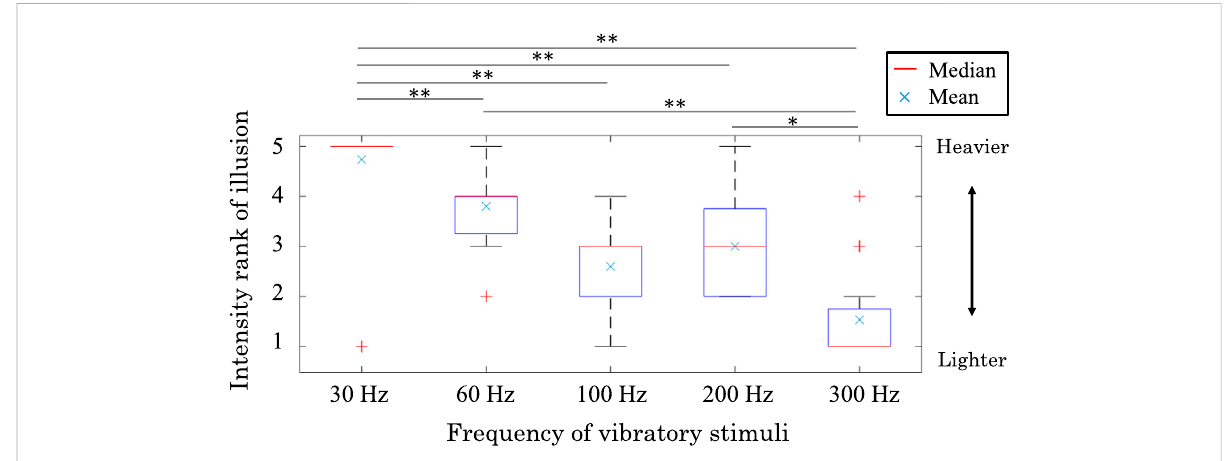
FIGURE 4 Box plots of intensity ranks of illusion by frequencies. * and ** indicate signi fi cant differences at 5 and 1% levels, respectively. Signi fi cant differences were investigated using the Wilcoxon signed-rank test with Bonferroni